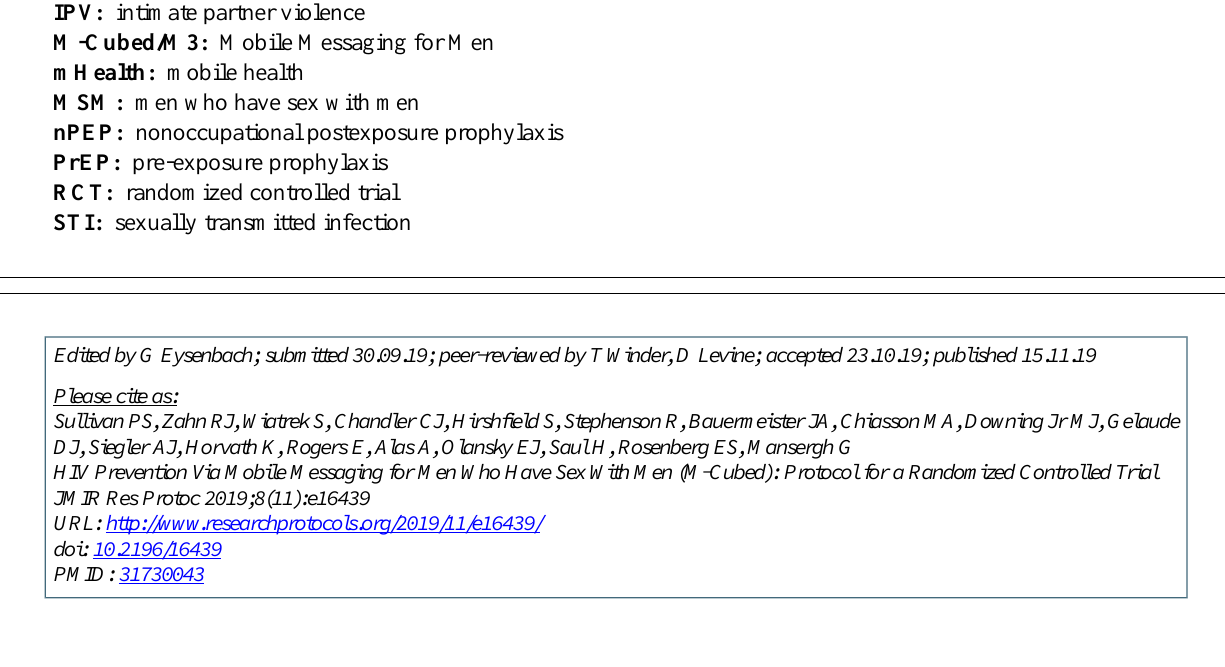
Abbreviations ART: antiretroviral therapy AUDIT: Alcohol Use Disorders Identification Test CESD-10: Centers for Epidemiological Studies on Depression 10-item scale DUDIT: Drug Use Dependency Identification Test IPV: intimate partner violence M-Cubed/M3: Mobile Messaging for